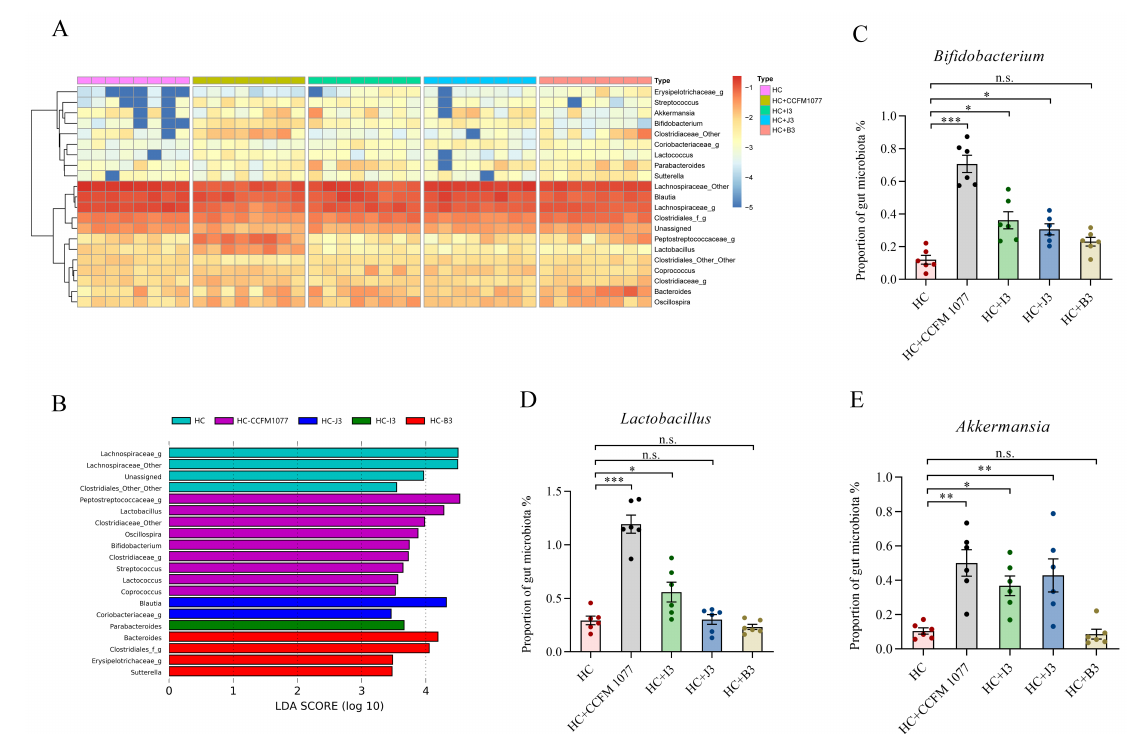
Figure 7. The relative abundance of the main genus after consumption of high-cholesterol diet and administration of B. longum strains. ( A ) Relative abundance (%) heatmap including all fecal samples. Sample clustering is shown on the left-hand side. ( B ) LEfSe analysis of the specific difference in the genus level in different groups. ( C ) The abundance of Bacterium in the feces. ( D ) The abundance of Lactobacillus in the feces. ( E ) The abundance of Akkermansia in the feces. Data are presented as means ± standard error of the mean, n = 6. *** represents p < 0.001, ** represents p < 0.01, * represents p < 0.05, n.s represent non-significant with p >